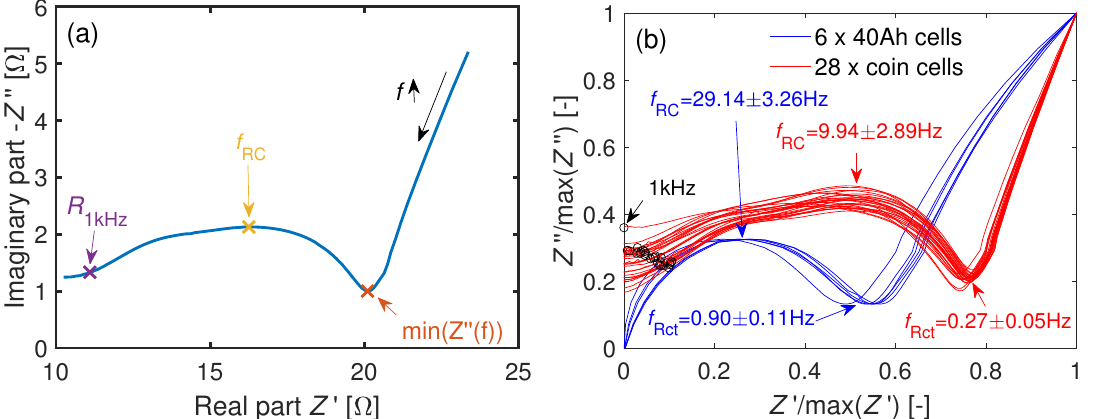
Figure 5. ( a ) Exemplary Nyquist plot of a coin cell. The definitions of the characteristic points are from Equations (5)–(7). ( b ) Comparison of the normed impedances at BOL of the 40Ah cells and the coin cells at T = 25 ◦ C. An additional second semi-circle at higher frequencies is observable for the coin cells. The characteristic frequencies are shown as µ ± 1 σ . The black circles mark the 1kHz values of the coin cells. The 1kHz values of the 40Ah-cells are not shown here due to their inductive imaginary part.